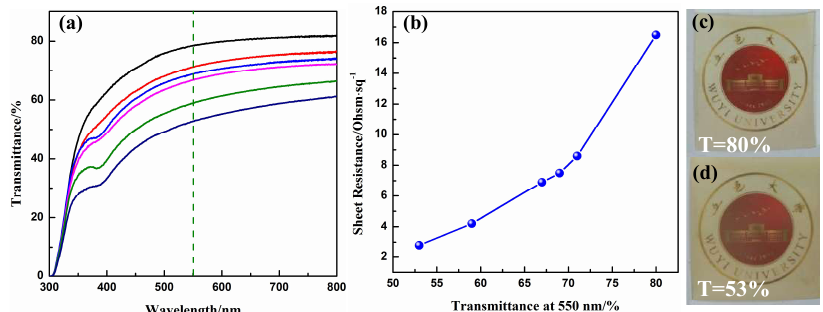
Figure 2. ( a ) Optical transmittance spectra of the Ag NWs-PI transparent electrodes with various transmittances of 53%, 59%, 67%, 69%, 71% and 80% at 550 nm; ( b ) Plots of sheet resistance versus transmittance at 550 nm of the Ag NWs-PI transparent electrodes (blue ball represents the value of sheet resistance at a certain transmittance at 550 nm); ( c , d ) Photographs of the composite films with the transmittances of 80% and 53%, respectively, overlaid on the logo of Wuyi University.